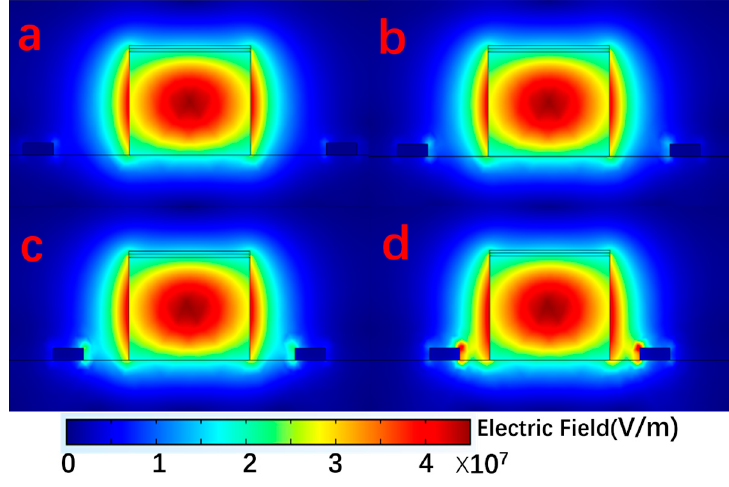
Figure 6. Power density of the electric field of the fundamental TE mode. The gap between the electrodes and the waveguide vary from 250 nm ( a ); 200 nm ( b ); 150 nm ( c ); to 100 nm ( d ).